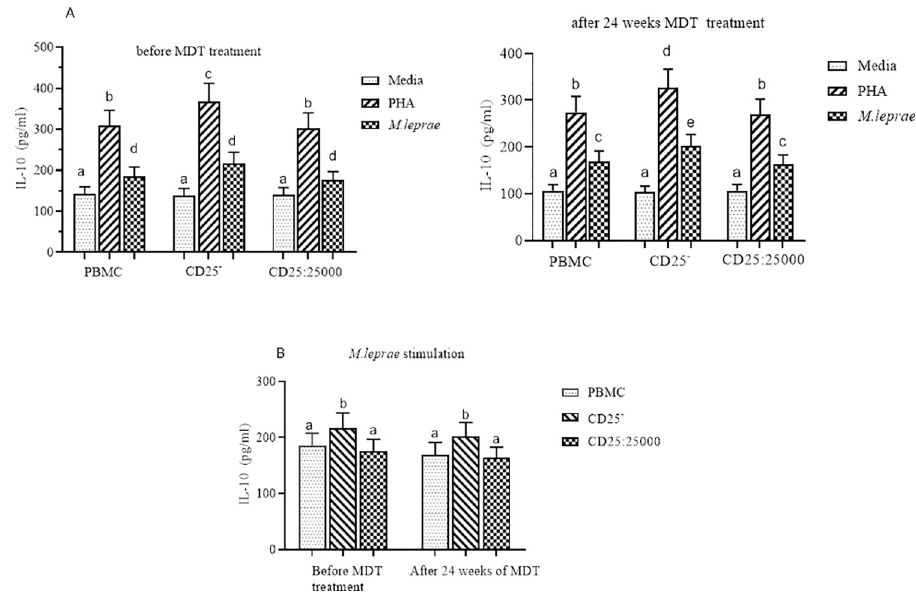
Fig 3. The effect of depletion of CD25 + cells on IL-10 secretion by PBMC from LL participants (n = 30): (Fig 3A) IL- 10 response to PHA and M . leprae WCS stimulation before and after 24 weeks of MDT: (Fog 3B) IL-10 response to M . leprae WCS stimulation in intact PBMC, CD25 + depleted PBMC and CD25 + cells re-added to CD25 + depleted cells from uncomplicated LL before and after 24 weeks of MDT. Each bar graphs shows mean ± 95% Confidence interval (CI). CI is calculated for mean difference. Any pair of different letters shows that the mean of IL-10 production of the two groups are statistically significantly different at p = 0.05 and any pair of similar letters indicates that the mean of IL-10 production the two groups are not statistically significantly different at P � 0.05 and 95% CI. Media indicate AIM-V medium only and it was used in the assay as negative control and PHA used as a mitogen (positive control).